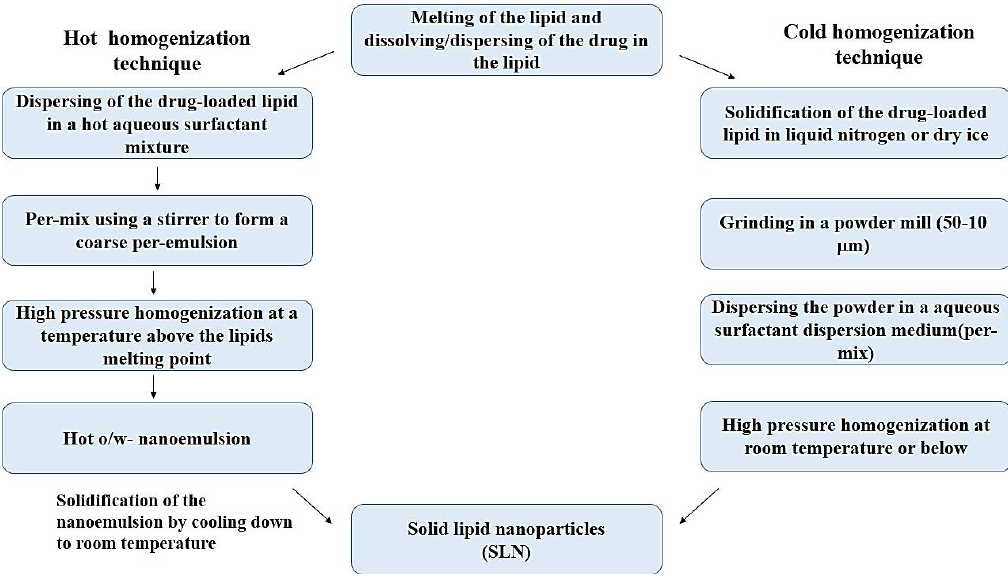
Fig. 4: Preparation of SLNs by cold and hot homogenization